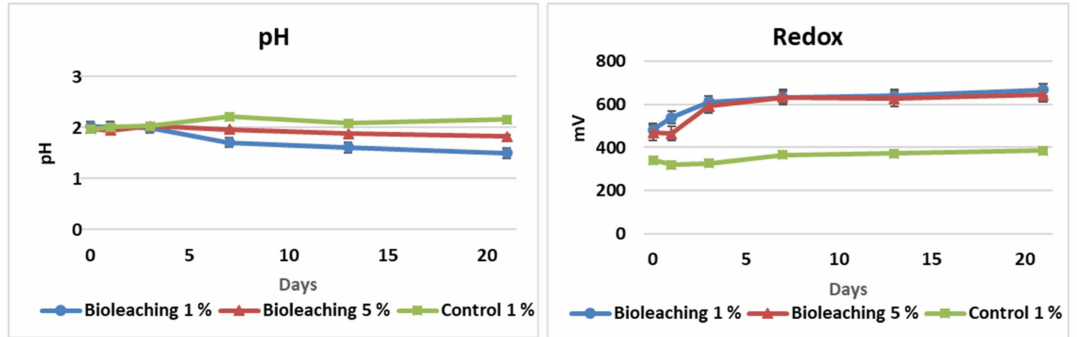
Figure 3. pH and redox potential in the shake flask bioleaching